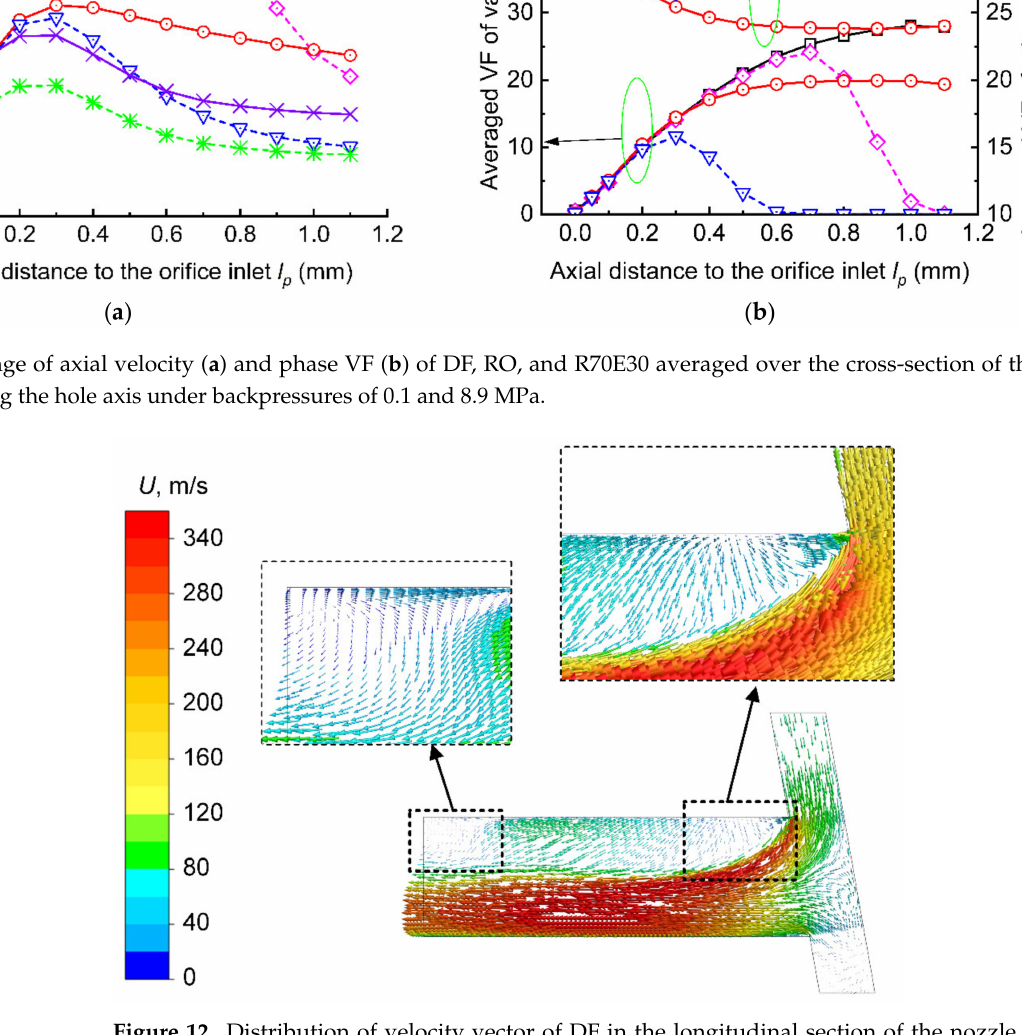
Figure 12. Distribution of velocity vector of DF in the longitudinal section of the nozzle hole at backpressure of 8.9